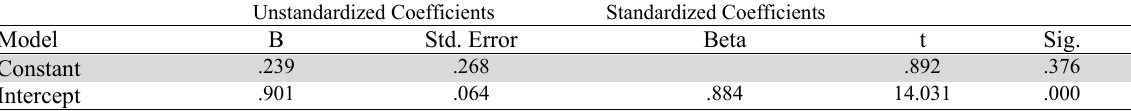
The results of the regression analysis Unstandardized Coefficients